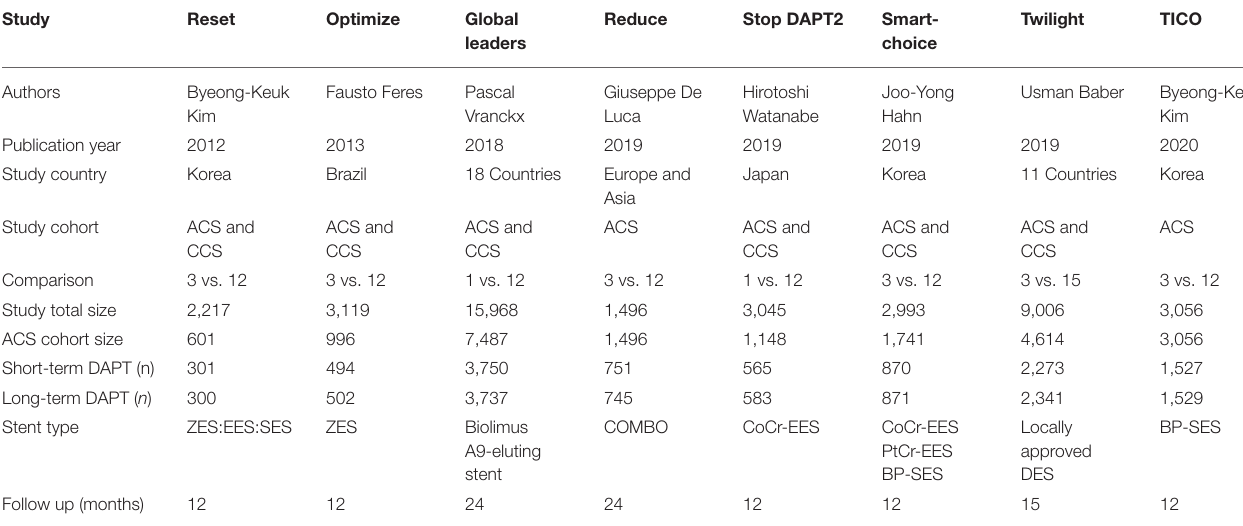
TABLE 1 | Baseline characteristics of the included trials.